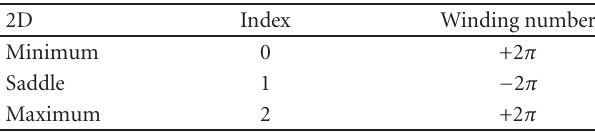
Table 1: Index and winding number of critical points in